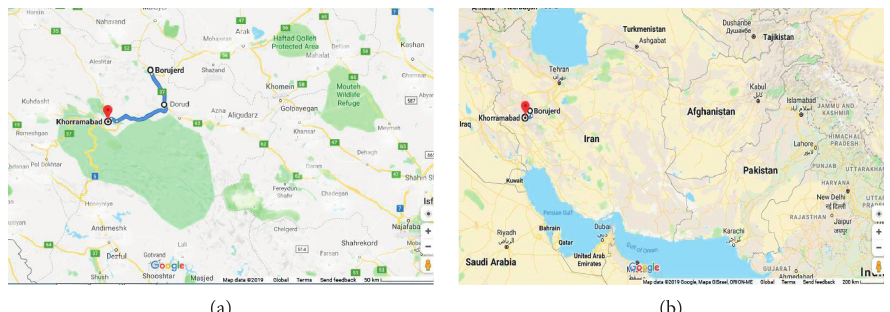
Figure 2: Schematic map of the case study (source: Google map). (a) Plan of the Borujerd-Khorramabad road. (b) Location map of the study